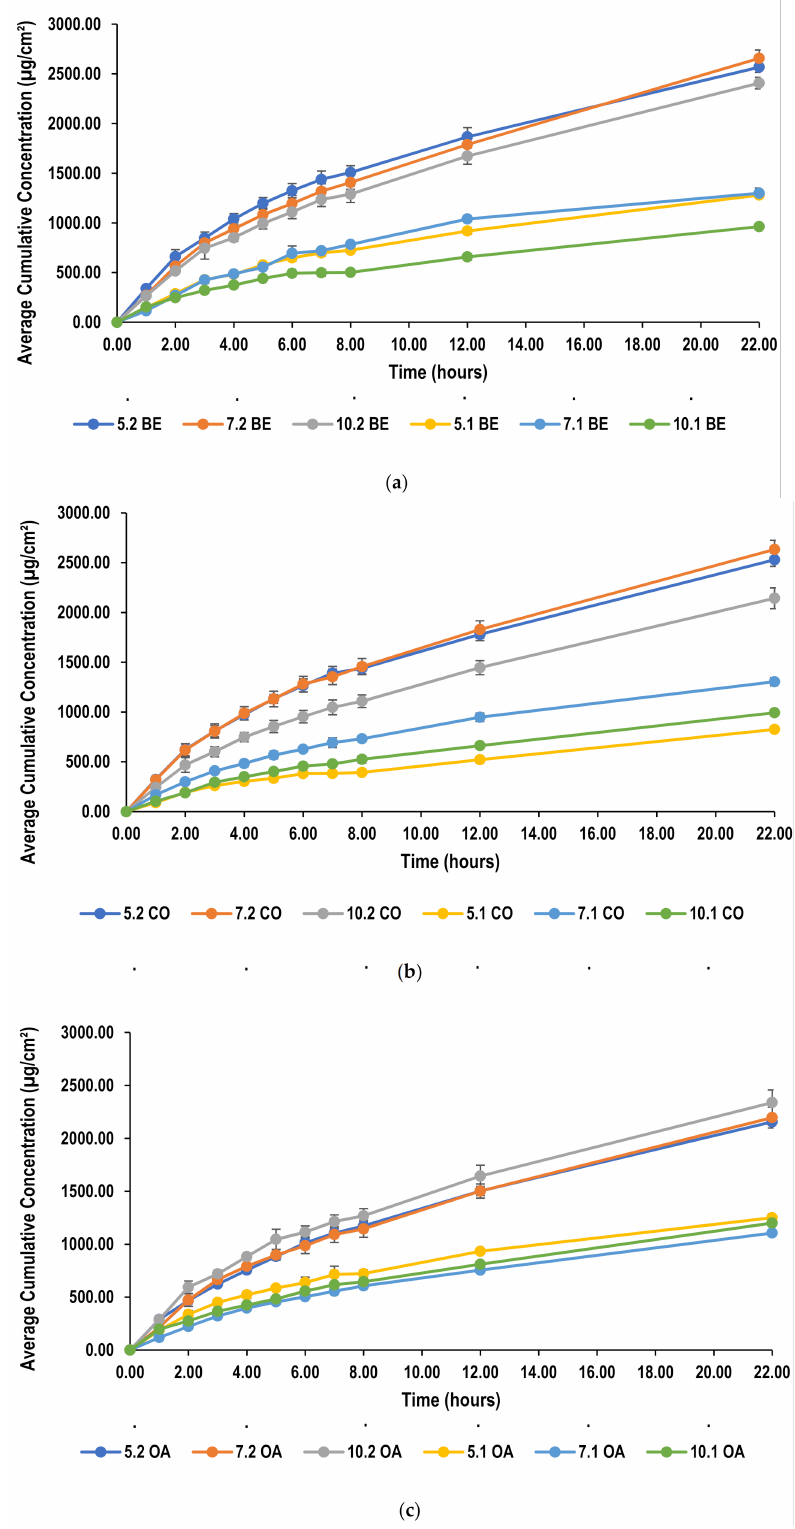
Figure 5. Permeation profile of lidocaine through PDMS from ( a ) beeswax formulations ( b ) coconut oil formulations and ( c ) oleic acid